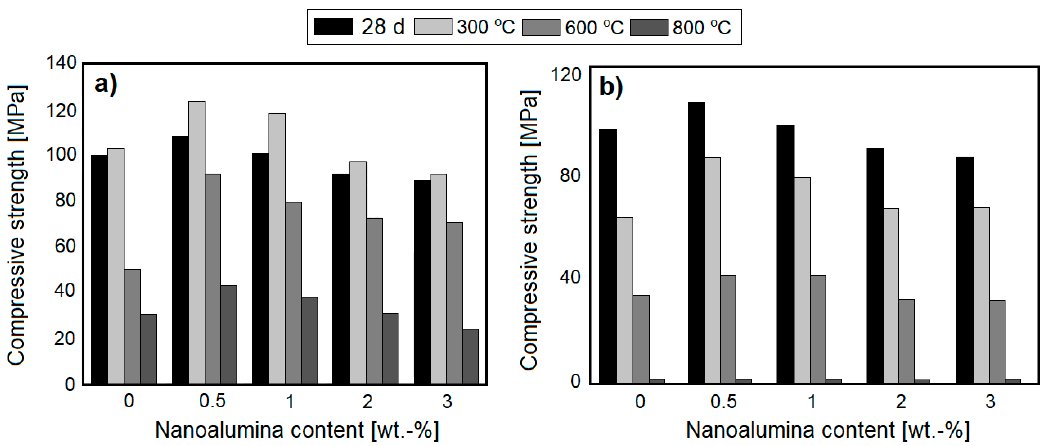
Figure 14. Compressive strength values of cement pastes containing nanoalumina (NA), after heating and cooling: gradually in air ( a ) and water quenching ( b ). Reproduced with permission from [41]. Copyright Springer Nature, 2017.